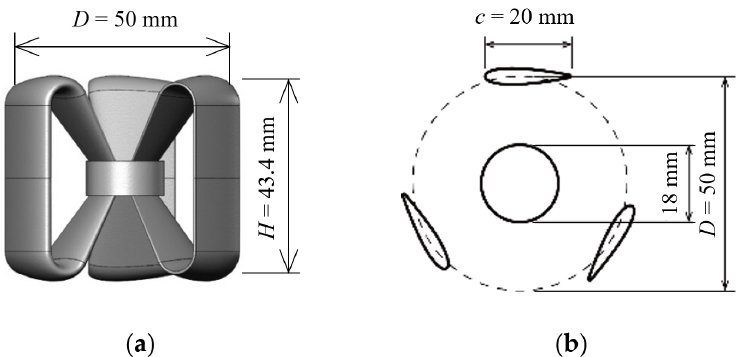
Figure 1. Butterfly wind turbine: ( a ) three-dimensional (3D) image; ( b ) cross ‐ section. Table 1. Comparison of the parameters of the vertical ‐ axis turbine. CO and IR represent co ‐ rotating and inverse ‐ rotating configurations, respectively. U is the uniform speed; D is the rotor diameter; R ec is the chord ‐ based Reynolds number; λ = R ω / V is the tip speed ratio; and σ = Bc /( π D ) is the solidity. Values marked with † are examples of nonequilateral ‐ triangular cluster design consisting of three VAWTs.